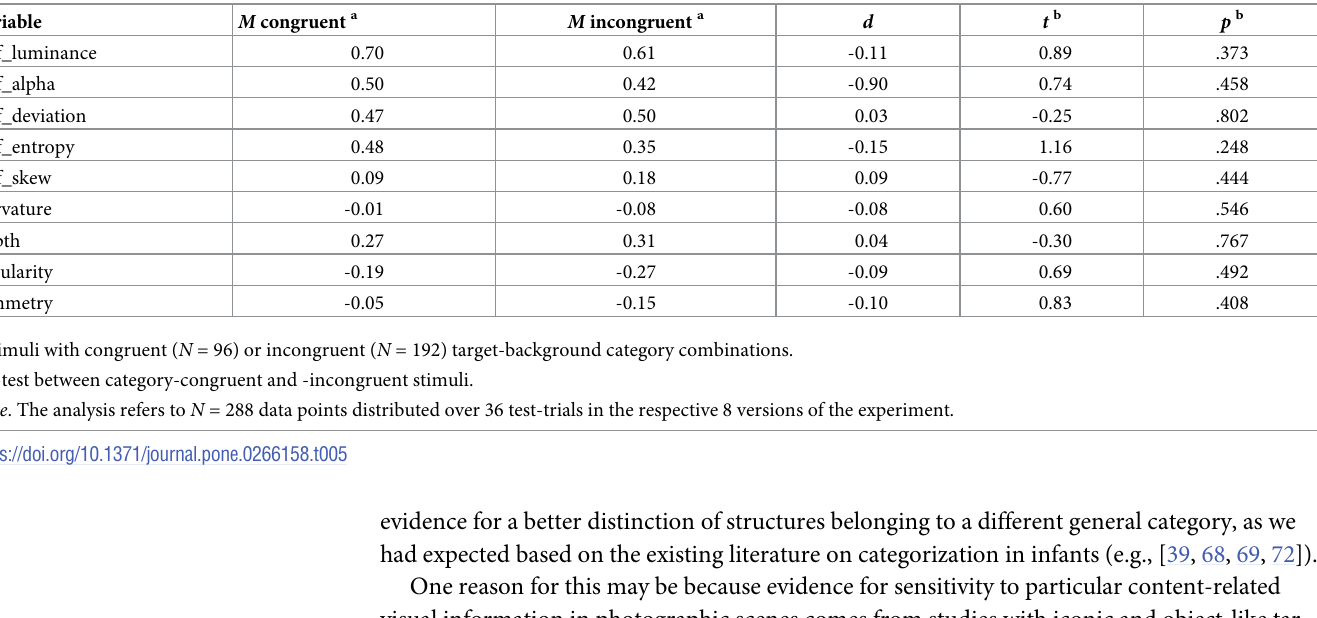
Table 5. Visual properties as function of